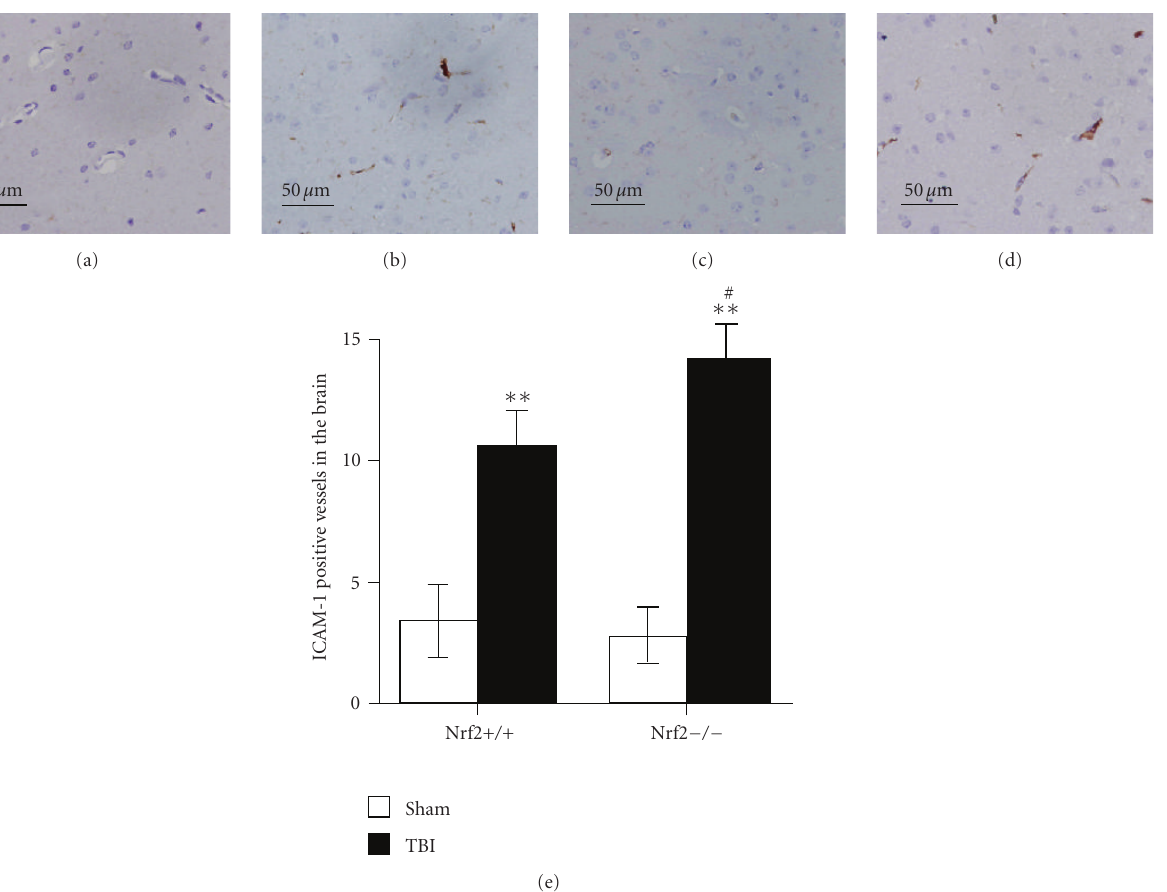
Figure 4: Expression of ICAM-1 in the cortex of sham and injured Nrf2 (+/+) and Nrf2 ( − / − ) mice. Immunohistochemical staining for ICAM-1 was performed in the cortex tissue sections of Nrf2 (+/+) and Nrf2 ( − / − ) mice 24 hours after TBI. (a), (c) Sham-operated Nrf2 (+/+) and Nrf2 ( − / − ) mice showing few ICAM-1-immunostained cerebral microvessels. (b) Injured Nrf2 (+/+) mice showing increased number of ICAM-1 positive vessels. (d) Injured Nrf2 ( − / − ) mice showing larger increment in the number of ICAM-1 positive vessels compared with injured Nrf2 (+/+) mice. (e) Quantitative analysis showed that the number of ICAM-1 positive vessels in brain was significantly increased after TBI and was greater in Nrf2 ( − / − ) mice than in Nrf2 (+/+) mice. Data represents mean ± SEM ( n = 5 per group). ∗∗ P < . 01 versus sham control of the same genotype. # P < . 05 versus injured wild-type